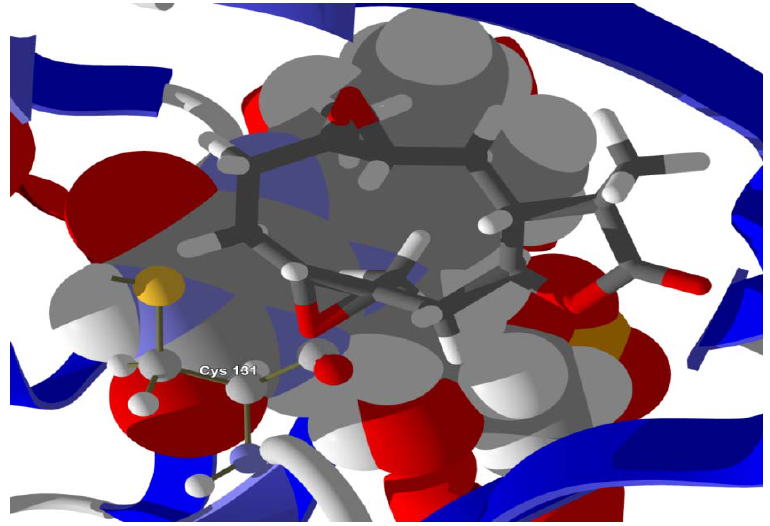
Figure 7. Lowest-energy docked pose of 11-epi-ivaxillin with L. major dihydroorotate dehydrogenase (LmajDHODH, PDB 3mhu). The cofactor, riboflavin monophosphate, is shown as a space-filling